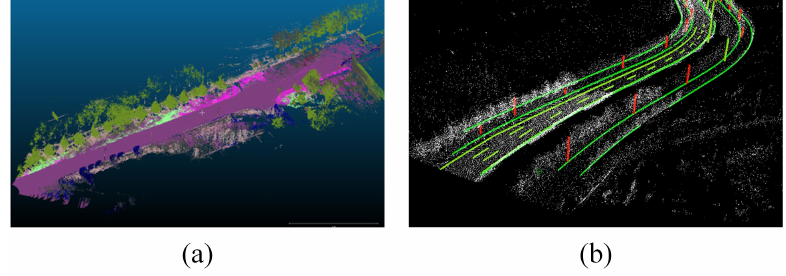
Figure 1. Different types of High Definition (HD) map—( a ) point cloud map with semantic labels; ( b ) vector HD map of a typical urban